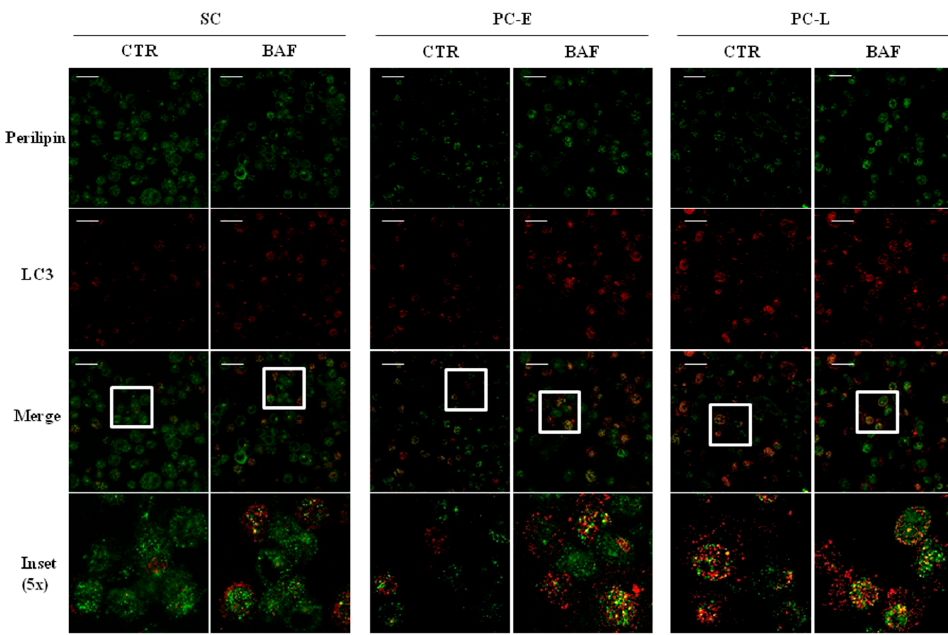
Figure 5. LC3-stained autophagosome spots co-localize with perilipin-stained LD suggesting LD clearance through autophagy. Immunofluorescence for perilipin ( green ) or LC3 ( red ) was performed on MSC, PC-E and PC-L, cultured in the absence (CTR) or presence of the lysosomal degradation inhibitor bafilomycin A1 (BAF). Yellow spots, indicating LC3-perilipin co-localization, increase as function of differentiation and are more evident in BAF-treated cells. Representative images of three experiments. All images were taken at the same magnification Bar corresponds to 60 μ m. Insets correspond to further 5× enlargement.